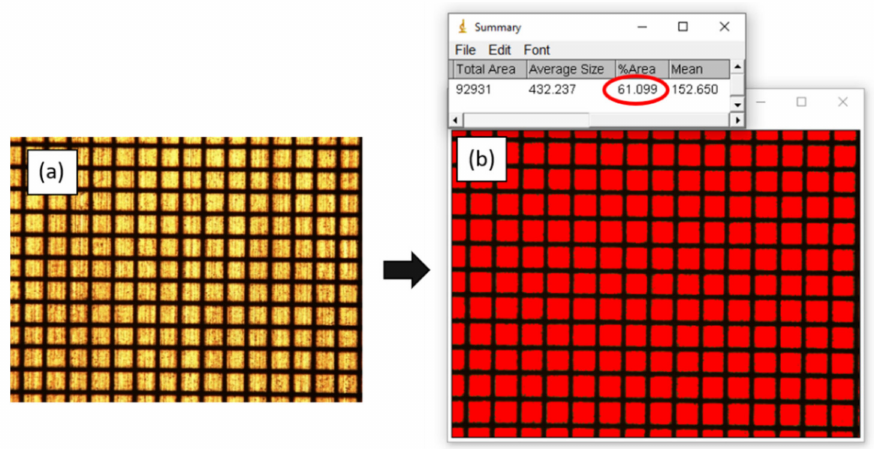
Figure 1. Example of image elaboration by ImageJ software. Here, a square lattice is reported (distance between consecutive scanning lines: h = 205 µ m): ( a ) optical microscope view, ( b ) after processing with ImageJ. The percentage of the textured surface (dark lines) is